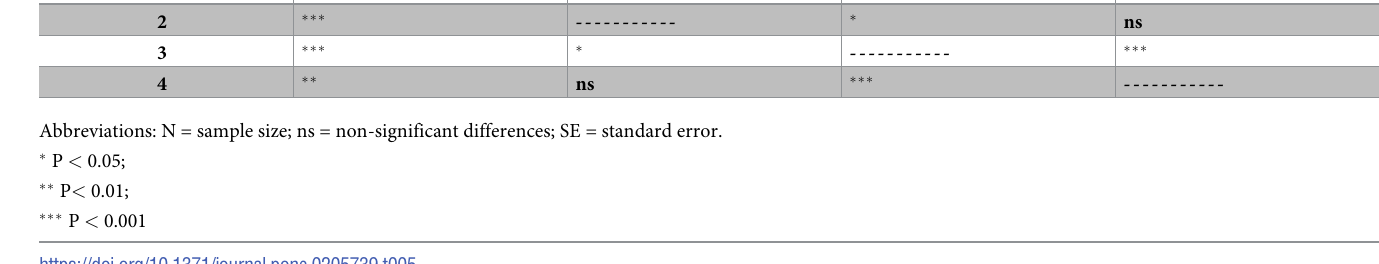
Table 5. Post hoc comparisons of SC/SL ratios among the four shell morphotypes using the unequal N HSD test. Variable